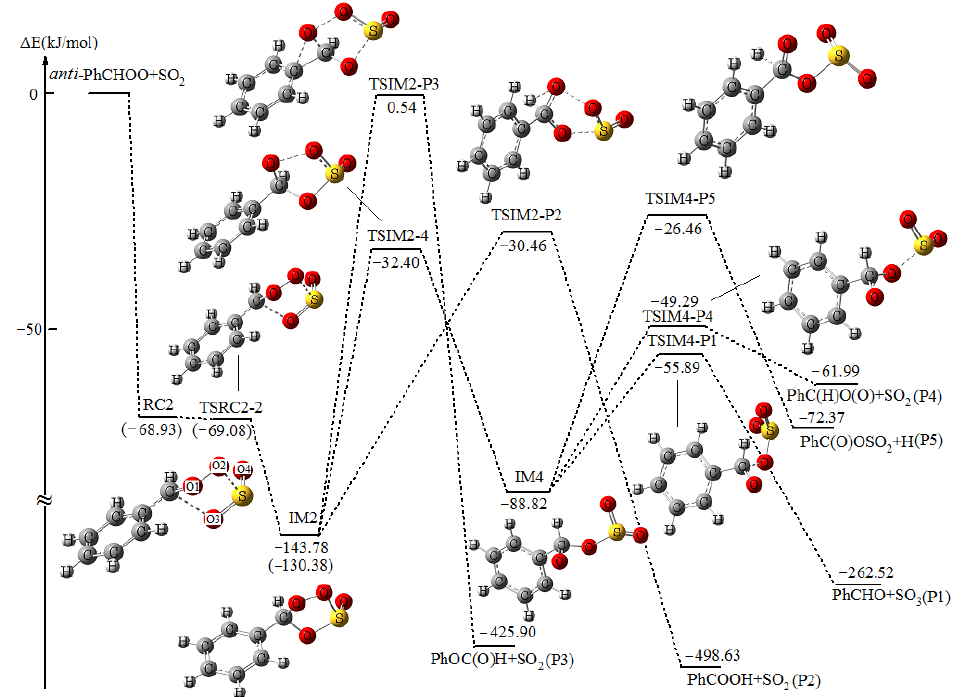
Molecules 2020 , 25 , x FOR PEER REVIEW Figure 2. Potential energy profile for the formation and subsequent reaction pathways of exo PhCHOOS(O)O (IM2) in the reaction of anti -PhCHOO + SO 2 at the UCCSD(T) // UB3LYP level with ZPE corrections. The values in parentheses are derived from UCCSD(T) // UBH&HLYP level with ZPE corrections.